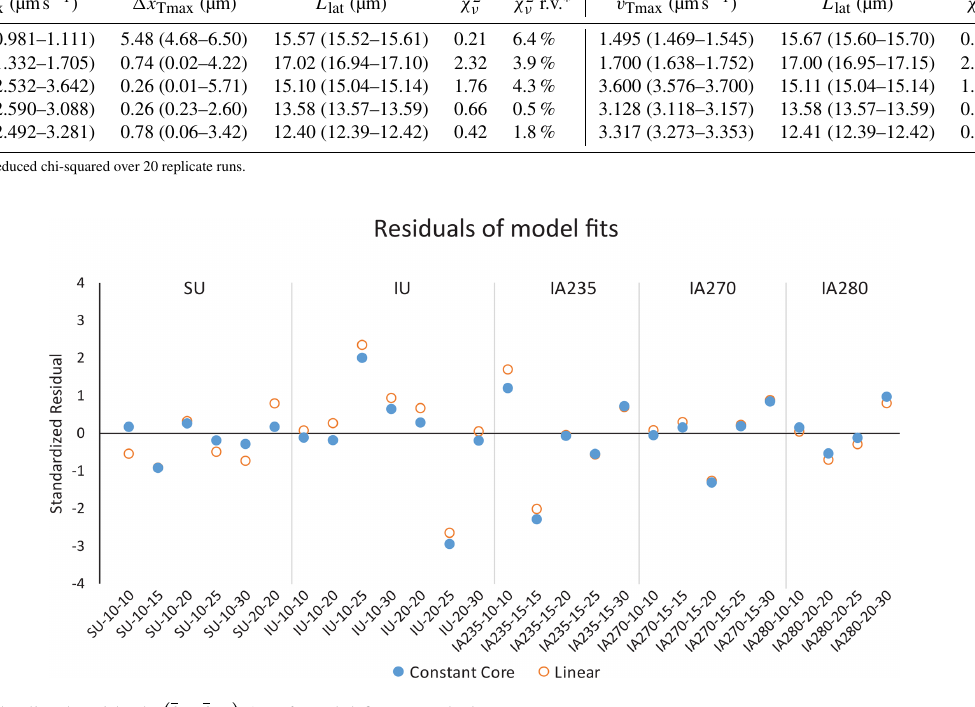
Figure 12. Standardized residuals